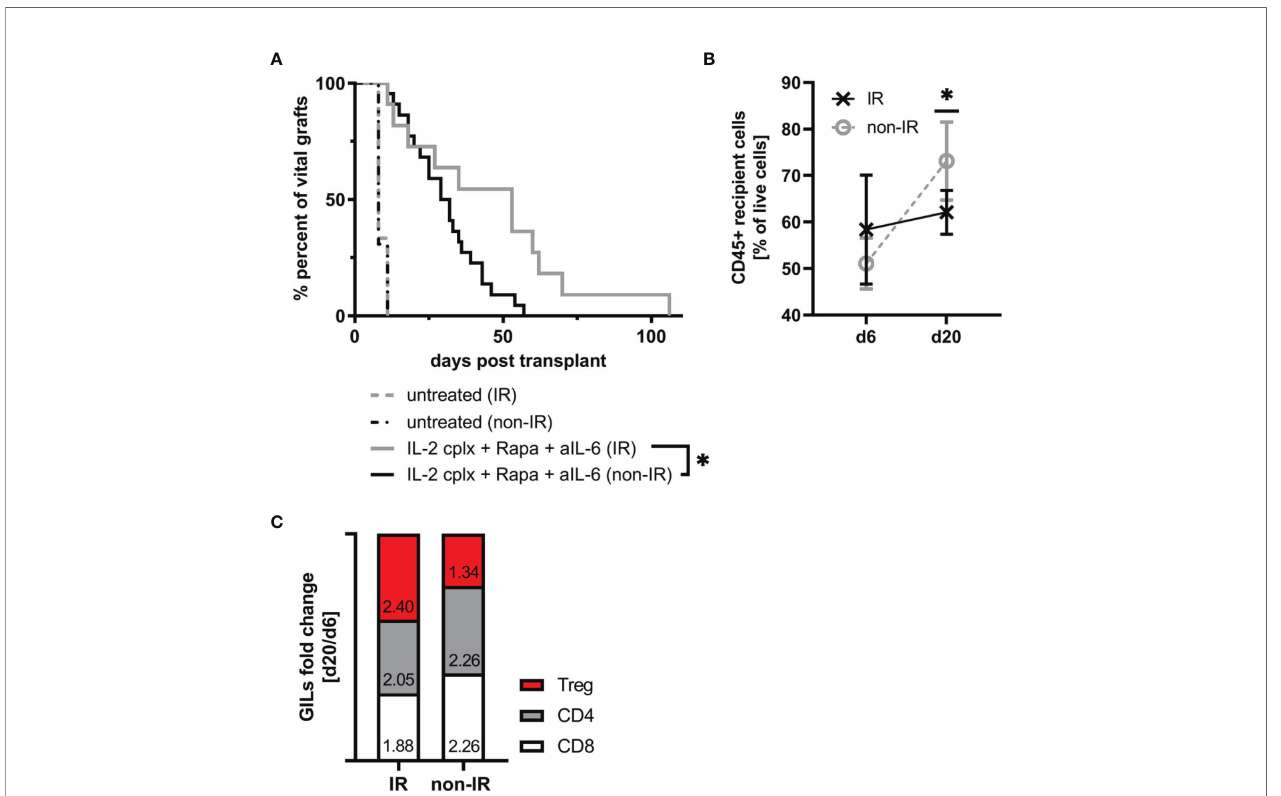
FIGURE 4 | Irradiation of donor skin graft prior to transplantation leads to signi fi cant prolongation of skin allograft survival in combination with IL-2cplx protocol treatment (MST: IR=53 days; non-IR=30.5 days; p = 0.0192, log-rank test). (A) Survival of irradiated (IR) and non-irradiated (non-IR) skin grafts on mice treated with (IR: n = 8; non-IR: n = 8) or without (IR: n = 11; non-IR: n = 22) a combination of IL-2 complexes, Rapamycin and a short term treatment of anti-IL-6. Survival proportions of at least two independent experiments are shown. (B) Mean frequency of CD45+ graft in fi ltrating leucocytes on day 6 and day 20 after transplantation in irradiated (d6: n = 3; d20: n = 6) and non-irradiated (d6: n = 6; d20: n = 7) skin allografts transplanted on IL-2cplx protocol treated recipient mice. (C) Differences in fold change between d6 and d20 post transplantation in non-irradiated (left; d6: n = 6; d20: n = 7) and irradiated (right; d6: n = 3; d20: n = 6) skin allografts on IL- 2cplx protocol treated recipient mice. Calculation: Fold change was obtained by dividing the mean value of two independent experiments for d20 by the mean value of d6. Fold changes were normalized to values obtained for non-irradiated skin grafts (shown as baseline with value 0). Analysis (B, C) was performed using fl ow cytometry and mean percentages of two independent experiments are shown. (*P < 0.05; two-tailed t test with unequal